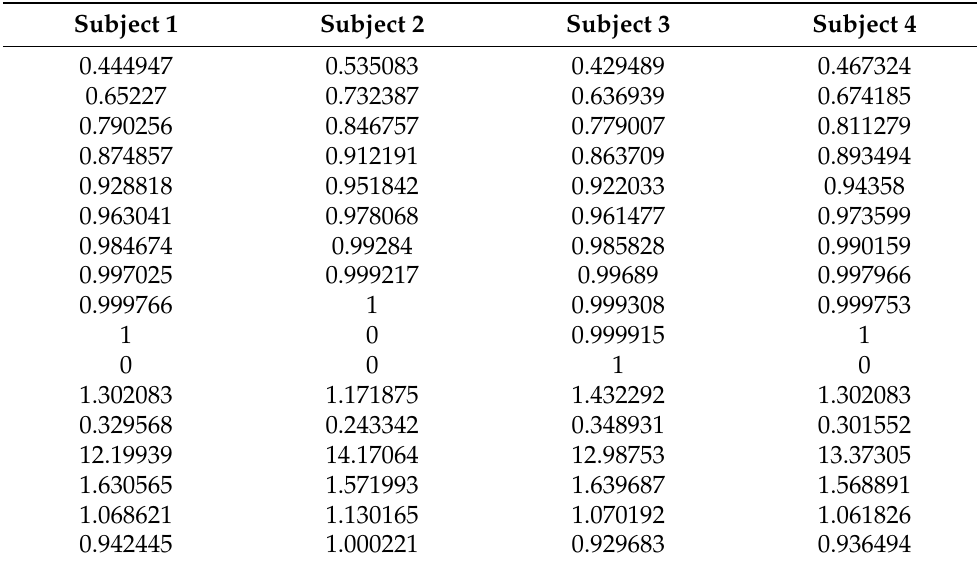
Table 4. A sample of feature vectors of four different